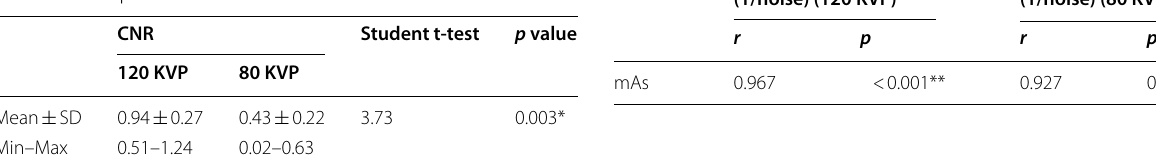
Table 9 LCD subjective